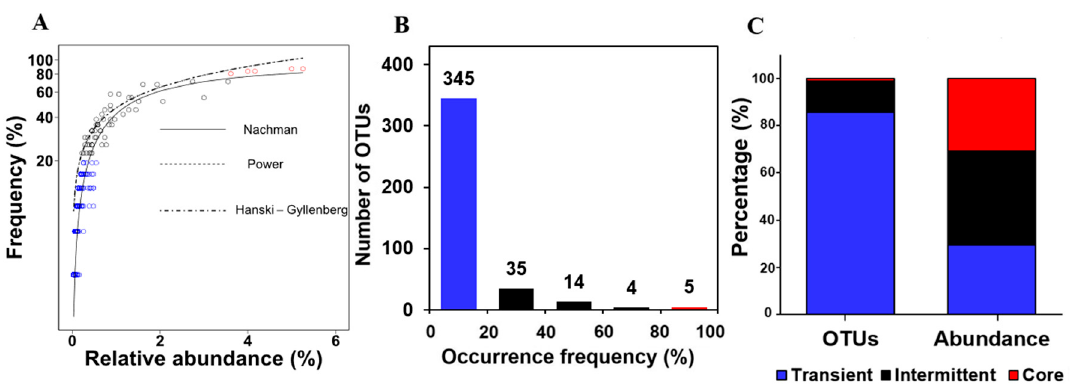
Sum of absolute difference and the coefficient of determination (R 2 ) were determined for estimating goodness of fit, as suggested previously [18,19]. 𝜇 and 𝑃 represent the relative abundance and occurrence frequency, respectively. α , β , and k denote model fitting parameters.